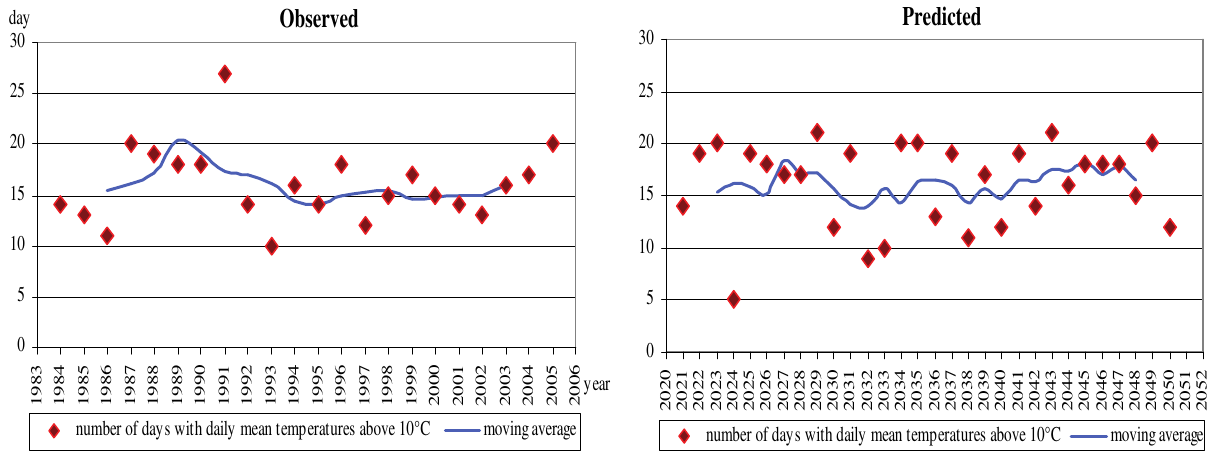
Figure 4: The observed (Left) and estimated (Right) number of days with daily mean temperatures above 10°C at Újfehértó. Estimation have been made by means of the RegCM 3.1 model for the period 10 days before bloom plus blooming time